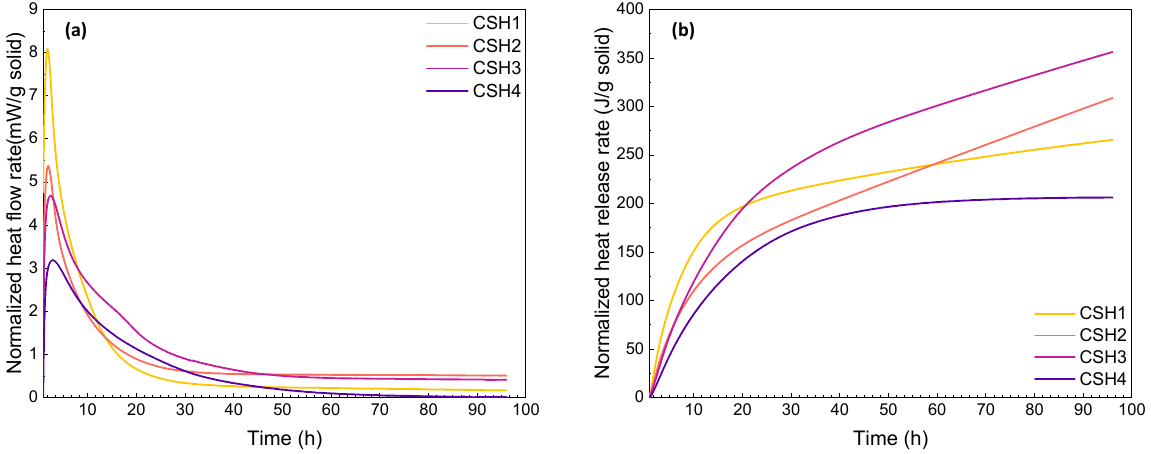
Figure 2. ( a ) Heat flow and ( b ) heat release rates of CSH gels measured by isothermal calorimetry at 35 °C over a reaction time of 0–96 h.